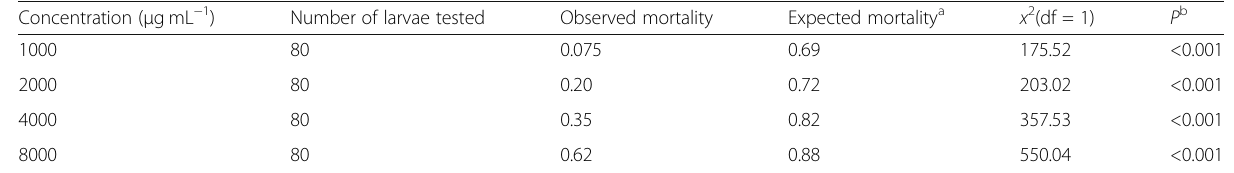
Table 4 Direct test of monogenic inheritance of resistance to acetamiprid by comparing expected and observed mortality of the backcross (F 1 ♀ × Lab-PK ♂ ) of Chrysoperla carnea Concentration ( μ g mL − 1 )